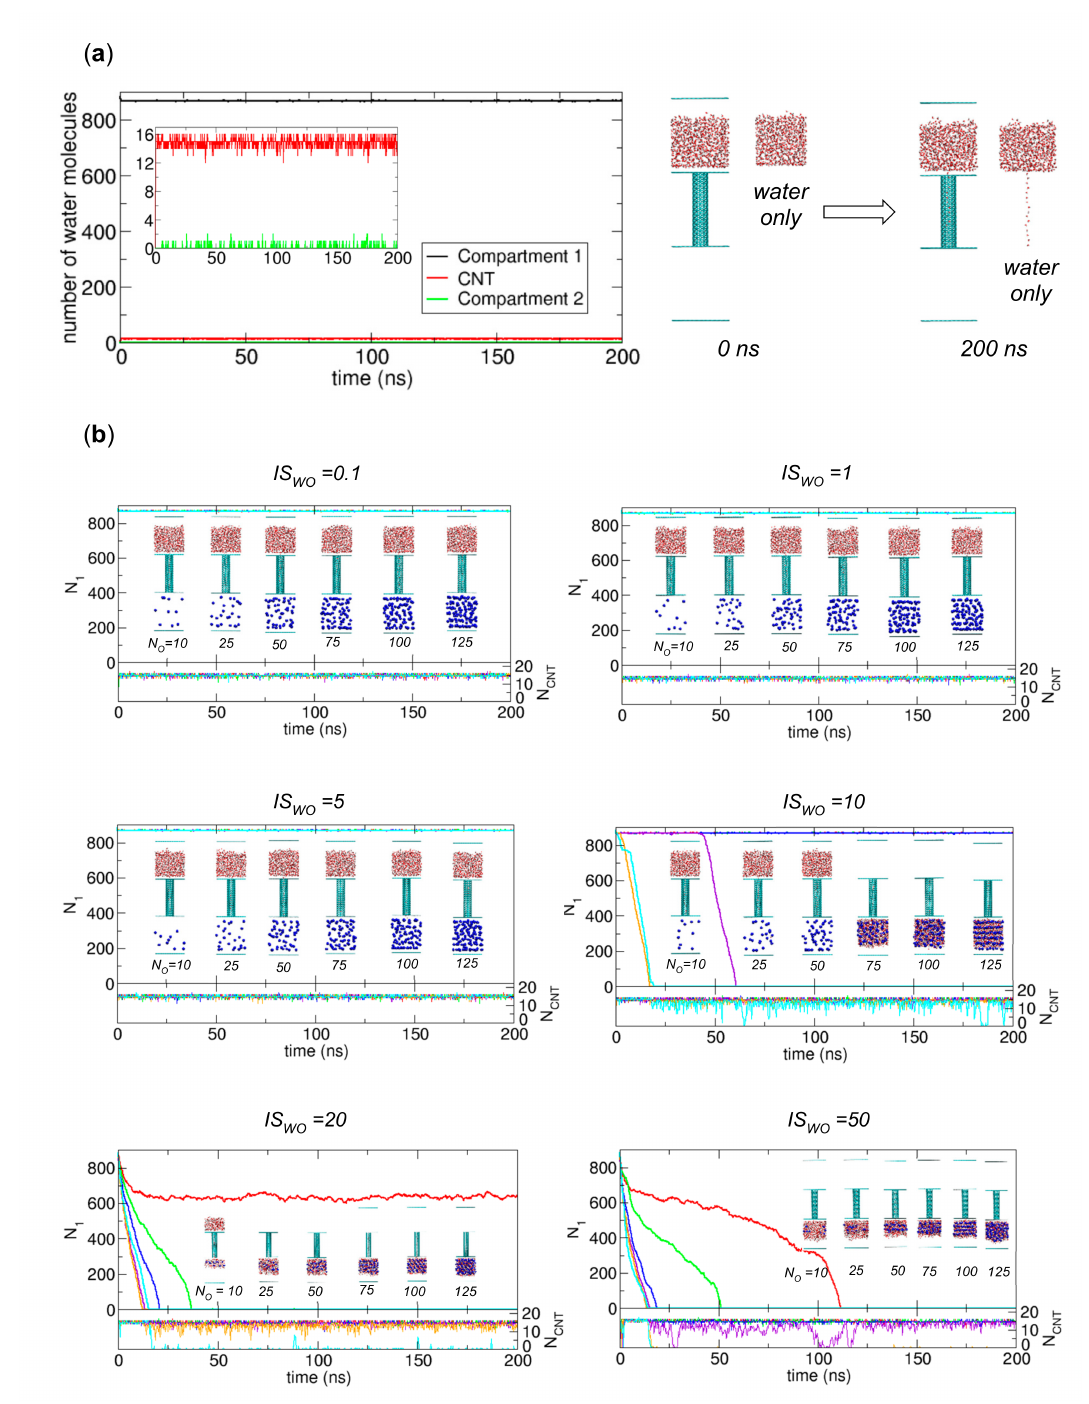
Figure 4. Simulation of water molecule transport in the systems composed of compartment walls that weakly interact with water molecules in the ( a ) absence and ( b ) presence of osmolytes with N O = 10 (red), 25 (green), 50 (blue), 75 (violet), 100 (orange), and 125 (cyan) and IS WO = 0.1, 1, 5, 10, 20, and 50. For each system, the numbers of water molecules in Compartment 1 ( N 1 ) and the CNT ( N CNT ) are plotted as functions of time. The insets show the final configurations of systems at 200 ns. Note that for all cases, the cavities in Figures 2 and 3